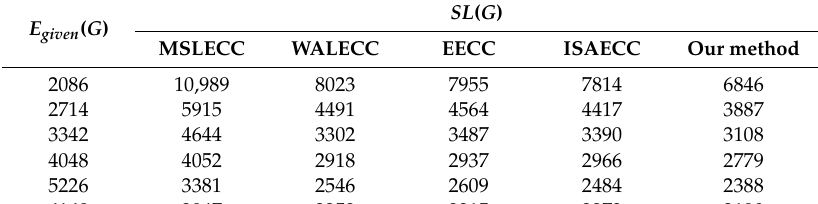
Table 4. Results of FFT applications with ρ = 32 for varying E given ( G ) .